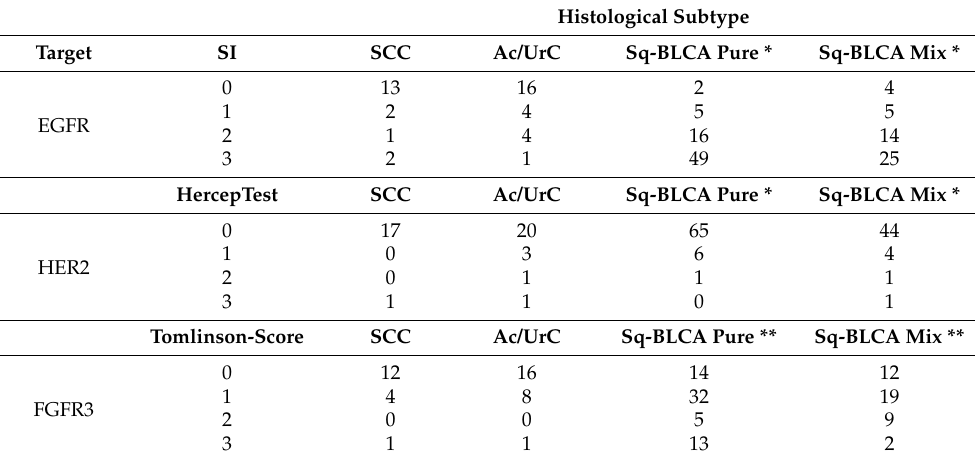
Figure 5. Dysregulation and activating mutations of receptor tyrosine kinases. ( A ) HE and immunohistochemical anti-EGFR staining of SCC ( i , ii ), AC/UrCs ( iii , iv ), and sq-BLCA ( v , vi ) tissues, respectively. Scale bar: 50 µ m. ( B ) Single nucleotide variations (SNVs) and copy number variations (CNVs) of tyrosine kinases (TKs) in different subtypes of bladder cancer of the TCGA dataset. Table 6. Immunohistochemical results of tyrosine kinase receptors in histological subtypes of blad- der